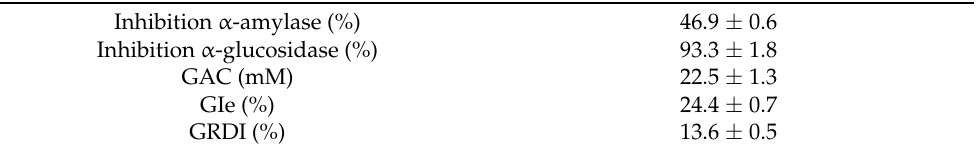
Table 2. Inhibition percentages of α -amylase and α -glucosidase, glucose adsorption capacity (GAC), estimated glycaemic index (GIe) and glycaemic retardation dialysis index (GRDI) of powdered co-product.